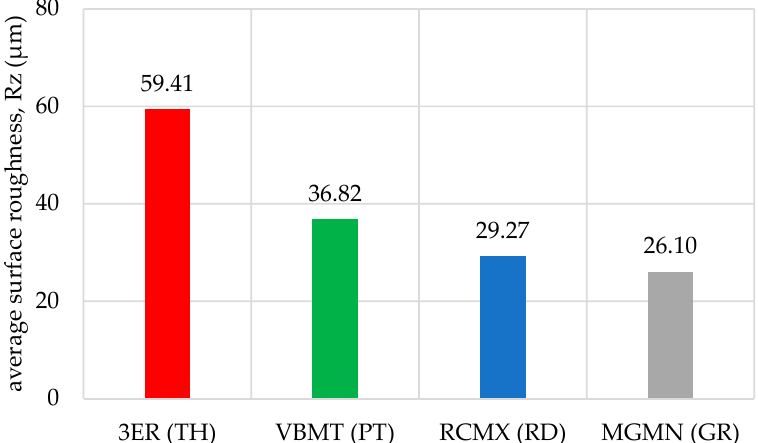
Figure 13. Mean roughness depth R z obtained in all tests depending on the insert used.